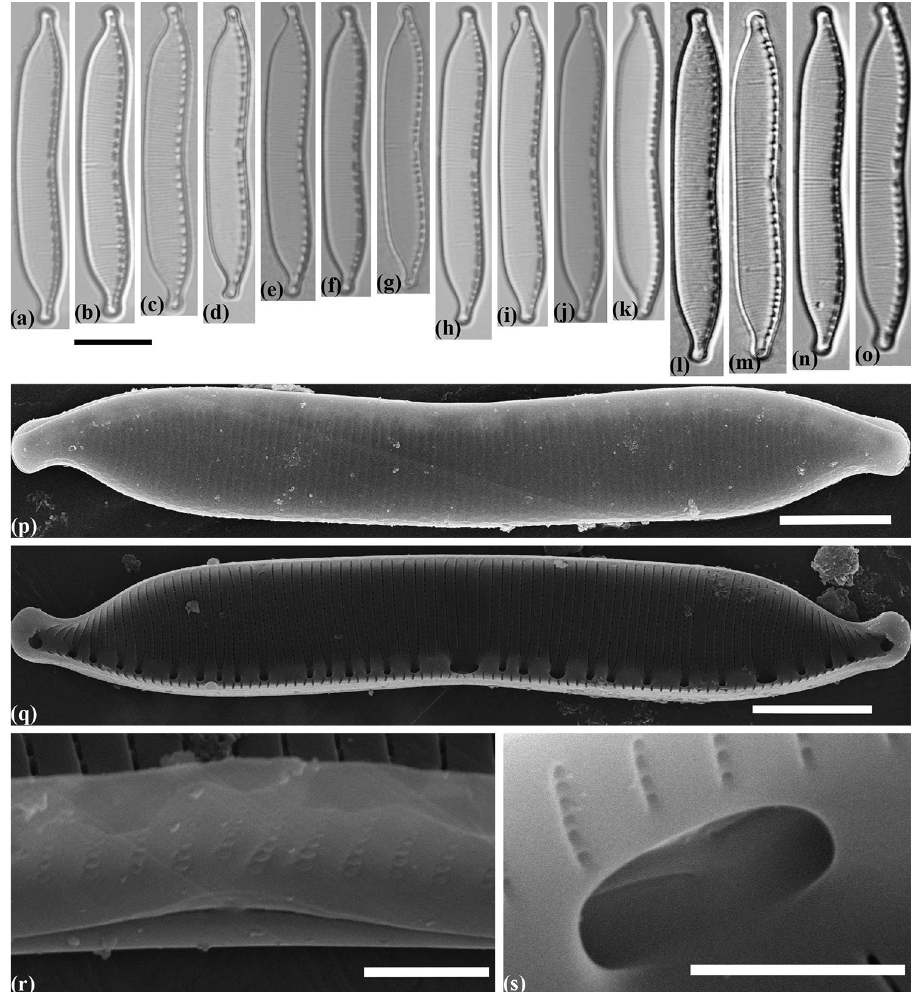
o ) H. amphioxys MZ–BH14. ( p ) Scanning electron micrograph of H. amphioxys MZ–BH9, exterior of valve. ( q ) Scanning electron micrograph of H. amphioxys MZ–BH8, interior of valve. ( r ) Scanning electron micrograph of H. amphioxys MZ–BH8, exterior of valve at valve center, showing almost straight the central raphe endings. ( s ) Scanning electron micrograph of H. amphioxys MZ–BH9, interior of valve at valve center, showing bent to opposite directions of the central raphe endings. Scale bars ( a – o ) = 10 µm, ( p , q ) = 5 µm, ( r , s ) = 1